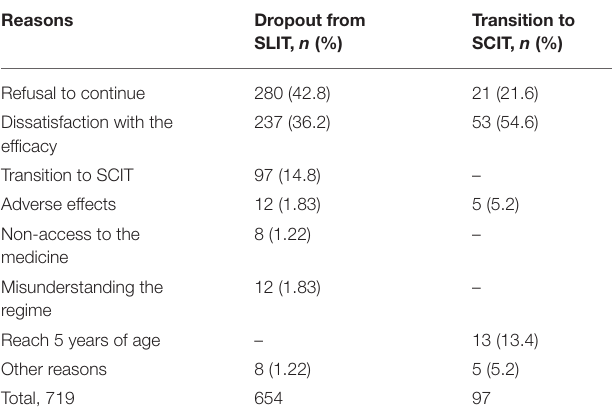
TABLE 2 | Reasons for dropout from SLIT or transition from SLIT to SCIT.